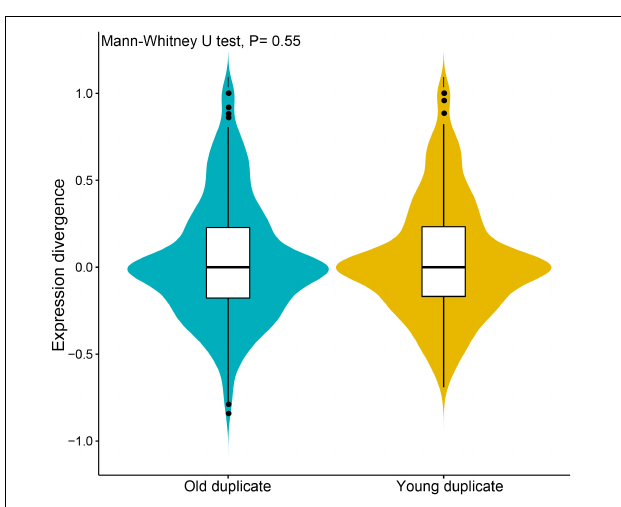
FIGURE 3 | Expression divergence analyses of young and old duplicate genes during Vernicia fordii different tissues and/or development stages. The divergence and similarity between expression profiles of duplicate genes by using pearson’s correlation coefficient